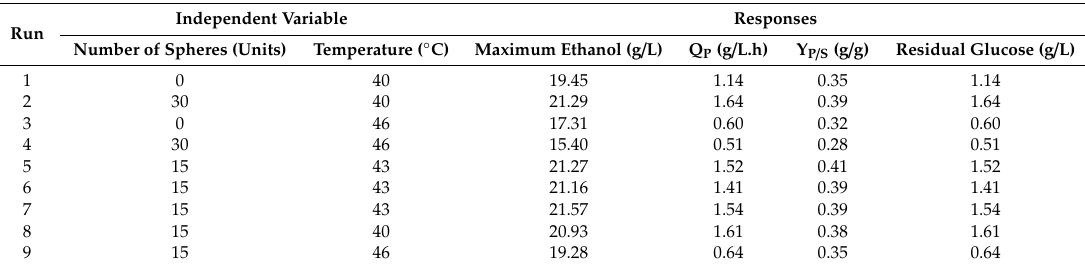
Table 5. Experimental conditions and results of batch SSF in the VBM reactor at 8% loading